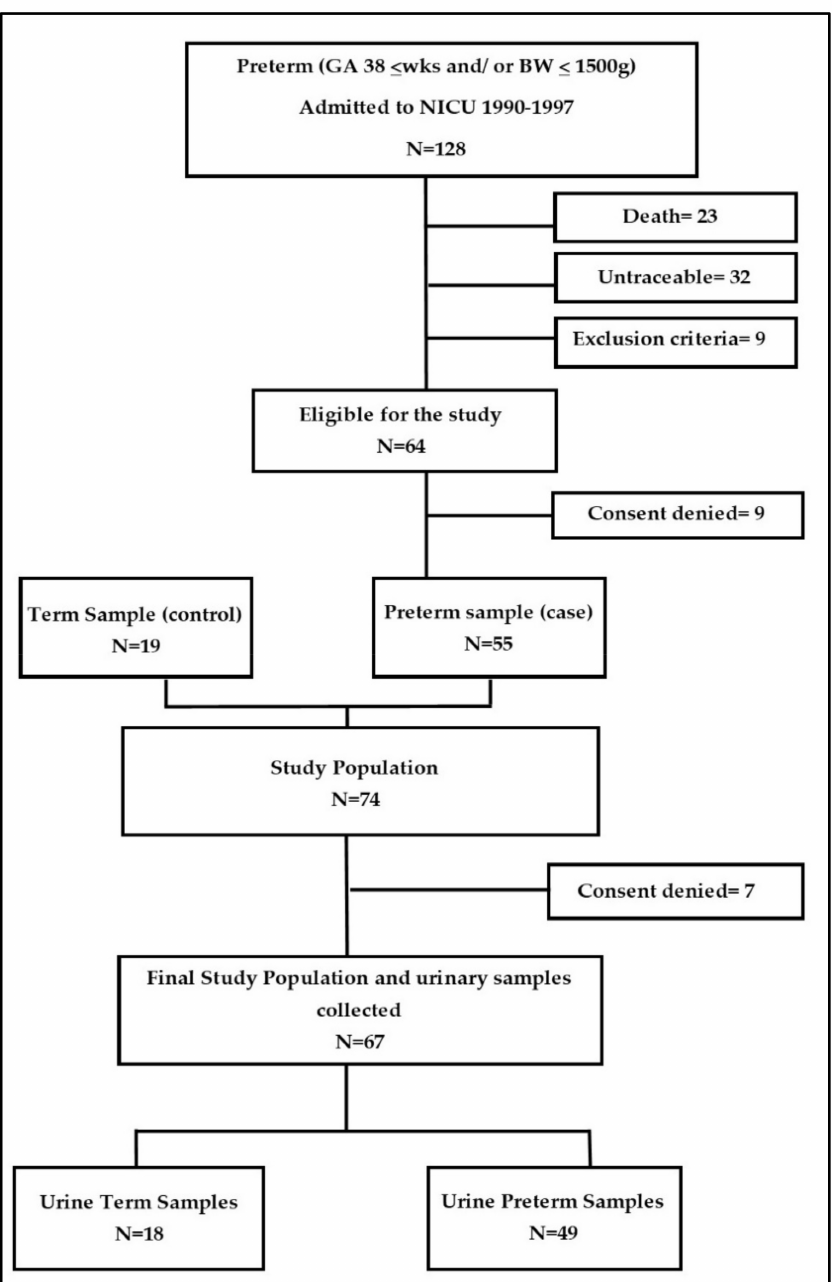
Figure 1. Participant flow chart; GA: gestational age; BW: body weight. Multivariate (chemometric) analysis allowed us to highlight differences in the urine metabolomic profile between young adults born preterm and young adults born at term. A non-supervised Principal Component Analysis (PCA) technique was performed to find clusters within the data set. The PCA did not show a clear difference between “preterm” and “term” clusters (Figure